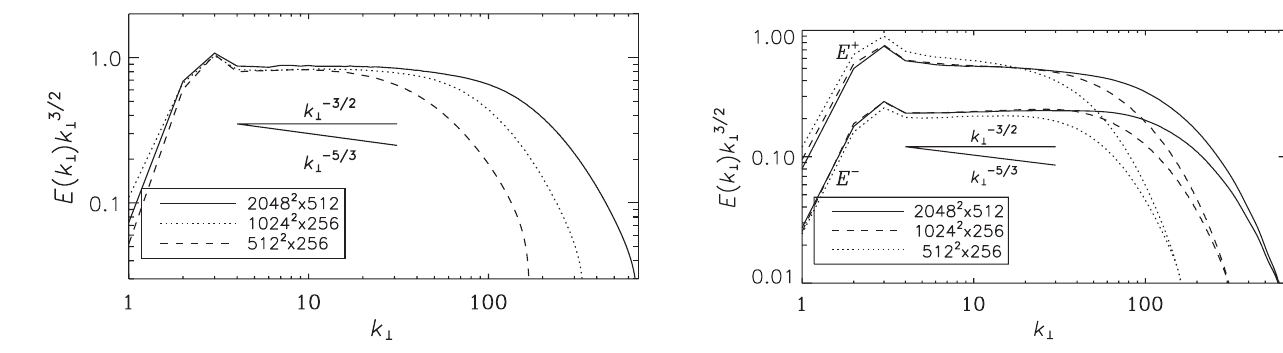
FIG. 1. Total field-perpendicular energy spectrum in balanced RMHD as the Reynolds number increases (cases RB1a, RB2a, and RB3a in Table I).